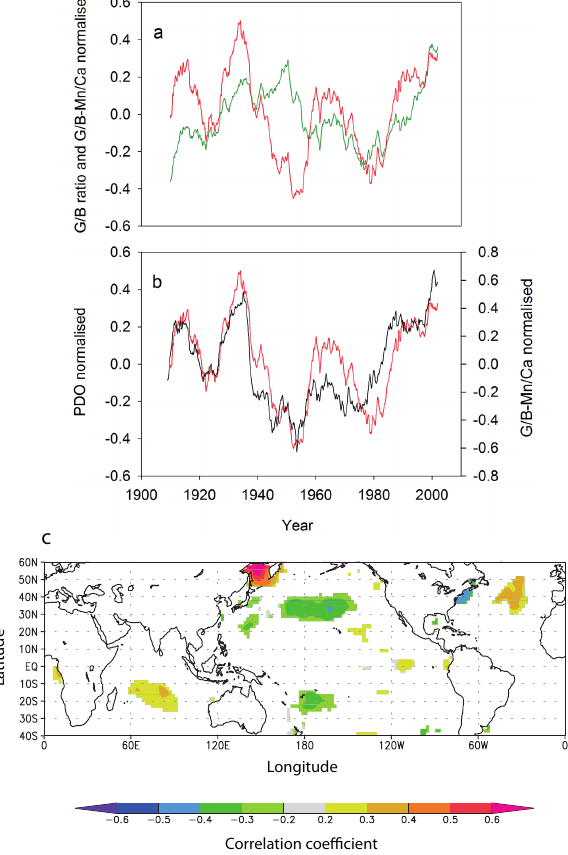
Fig. 7. The 11yr running means ( a , b ) of the normalised MAS1/3 (MAS1 and MAS3 combined; Appendix B) G/B composite record (green), normalised MAS1/3 G/B-Mn/Ca composite record (red) and the PDO (black). Note, with the removal of Mn/Ca from the G/B record, runoff is more in phase with the PDO. The spatial correlation of global SST (ERSSTv.3) with (c) the 360-month low pass filter of normalised MAS1/3 G/B-Mn/Ca composite indicates a PDO-like spatial SST patterns (Fig. 5a). Only correlations above 95% significance level are shown. Correlations were computed at http://climexp.knmi.nl/.